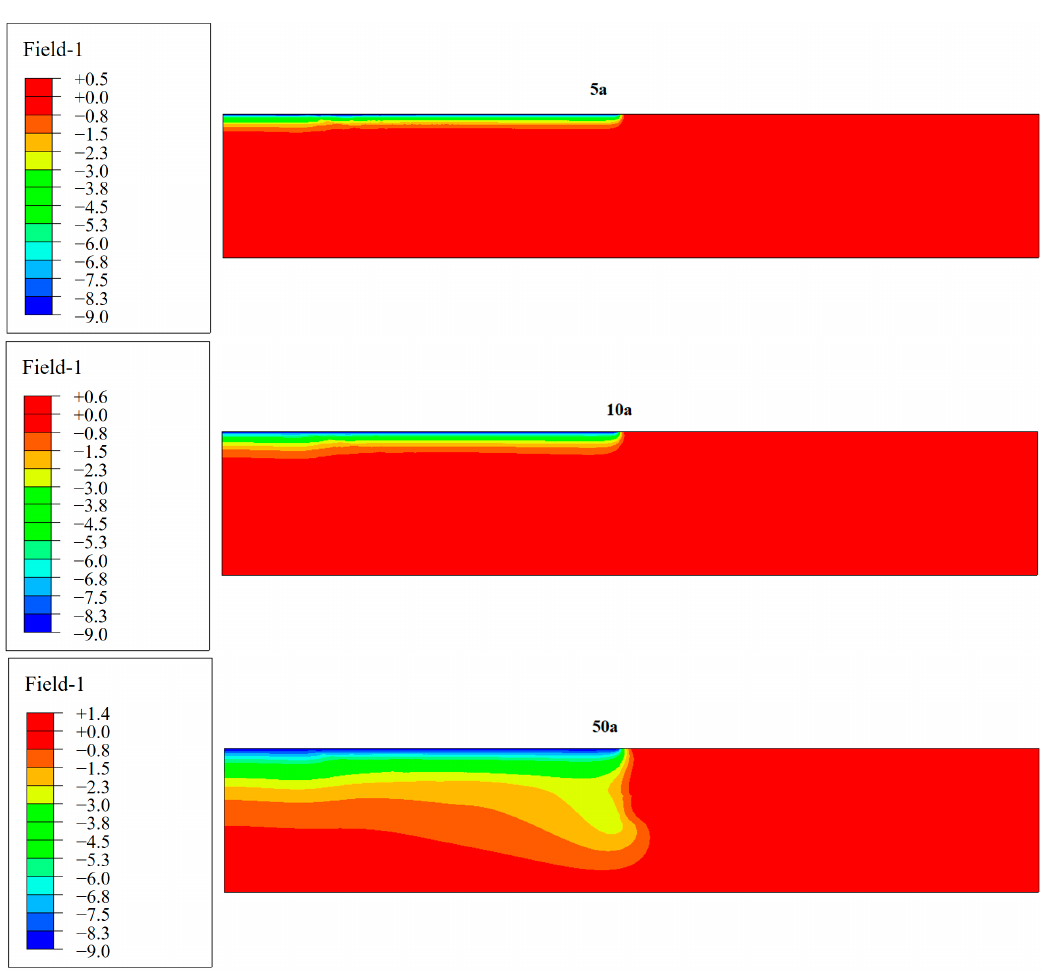
Figure 11. Temperature of bedrock at different times (unit: °C).